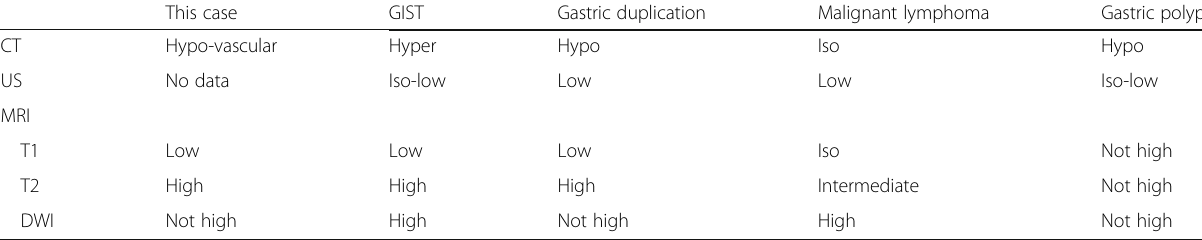
Table 1 Preoperative different diagnosis and typical findings by MRI, CT, and US This case